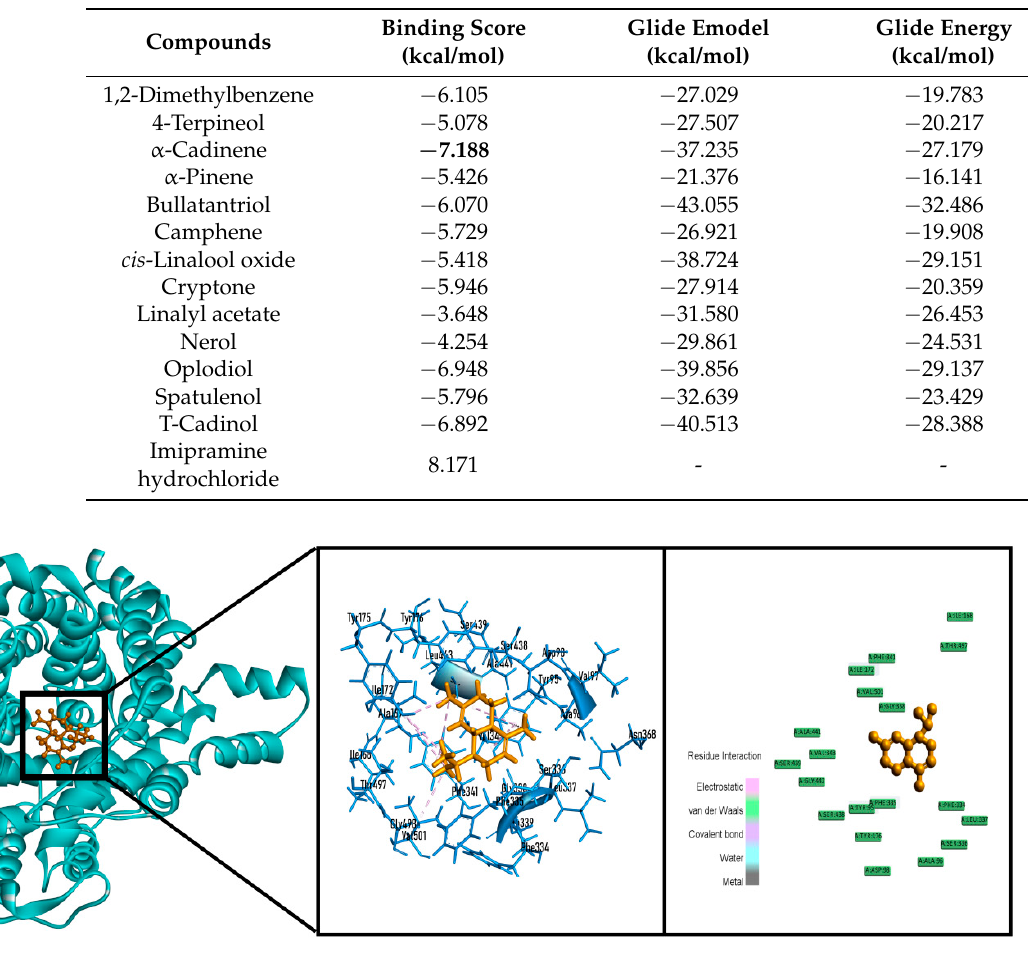
Figure 9. Best docked poses and 2D interactions of alpha-Cadinene with human serotonin receptor (PDB: 5I6X) for antidepressant activity.